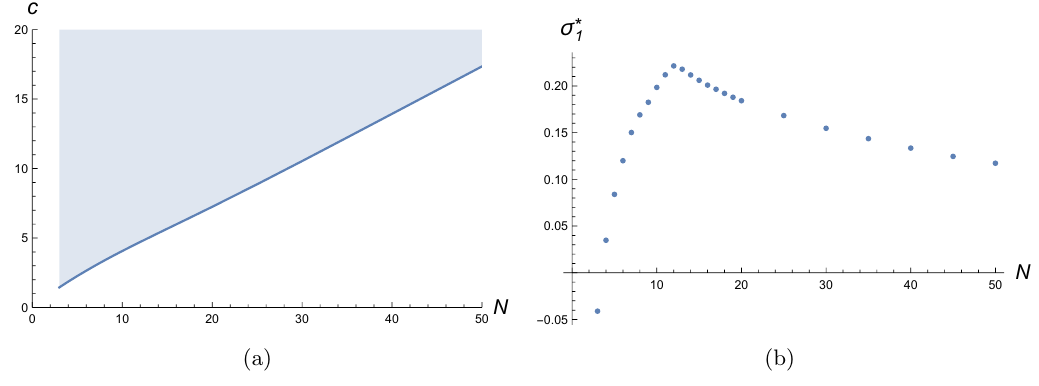
Figure 12 . The plots are constructed with N max = 30. Left : bound on the central charge as a function of N . The allowed region is depicted in blue. Right : the value of (cid:27) (cid:3) amplitudes with the minimal central